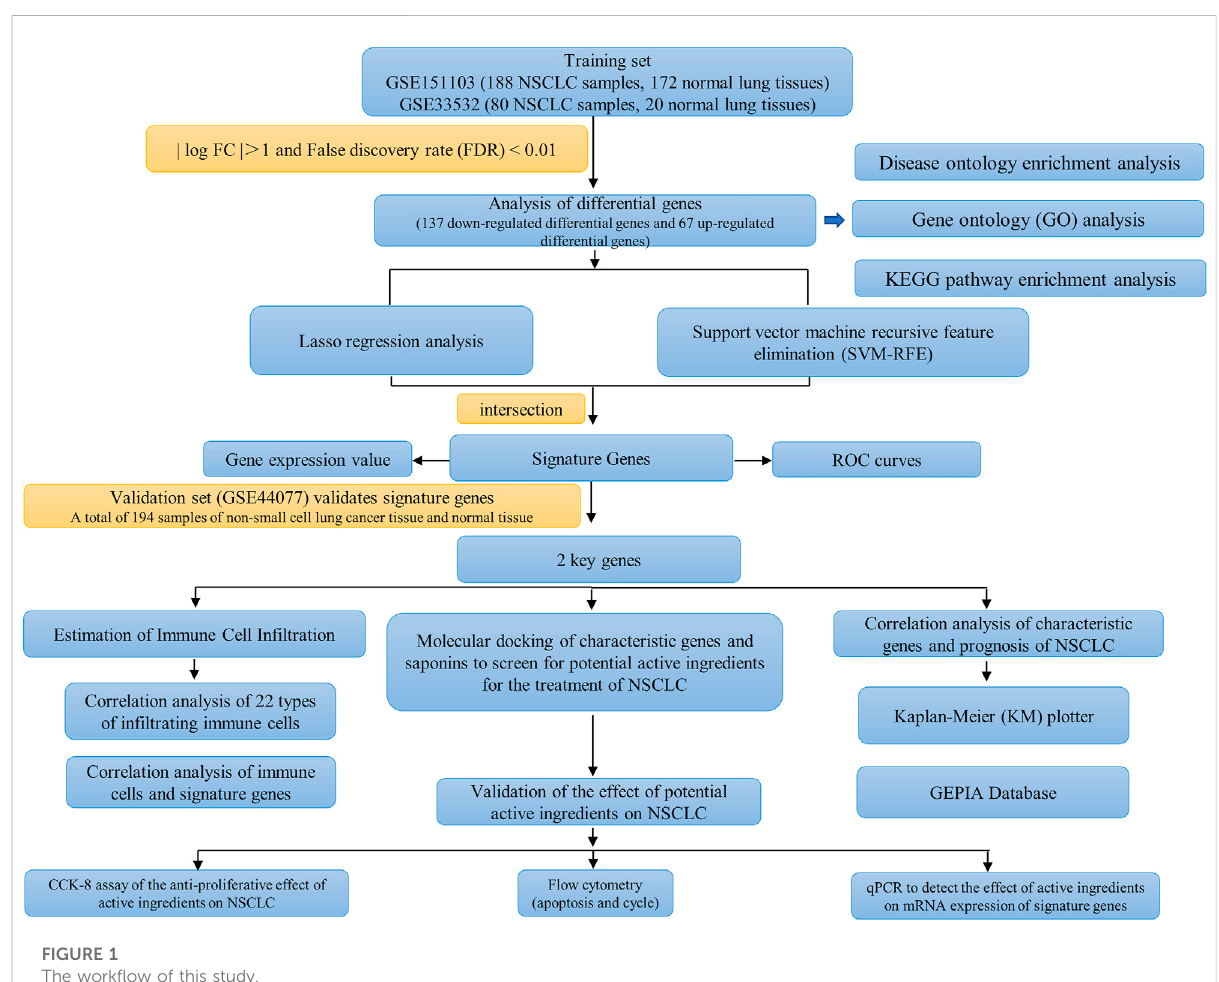
FIGURE 1 The work fl ow of this